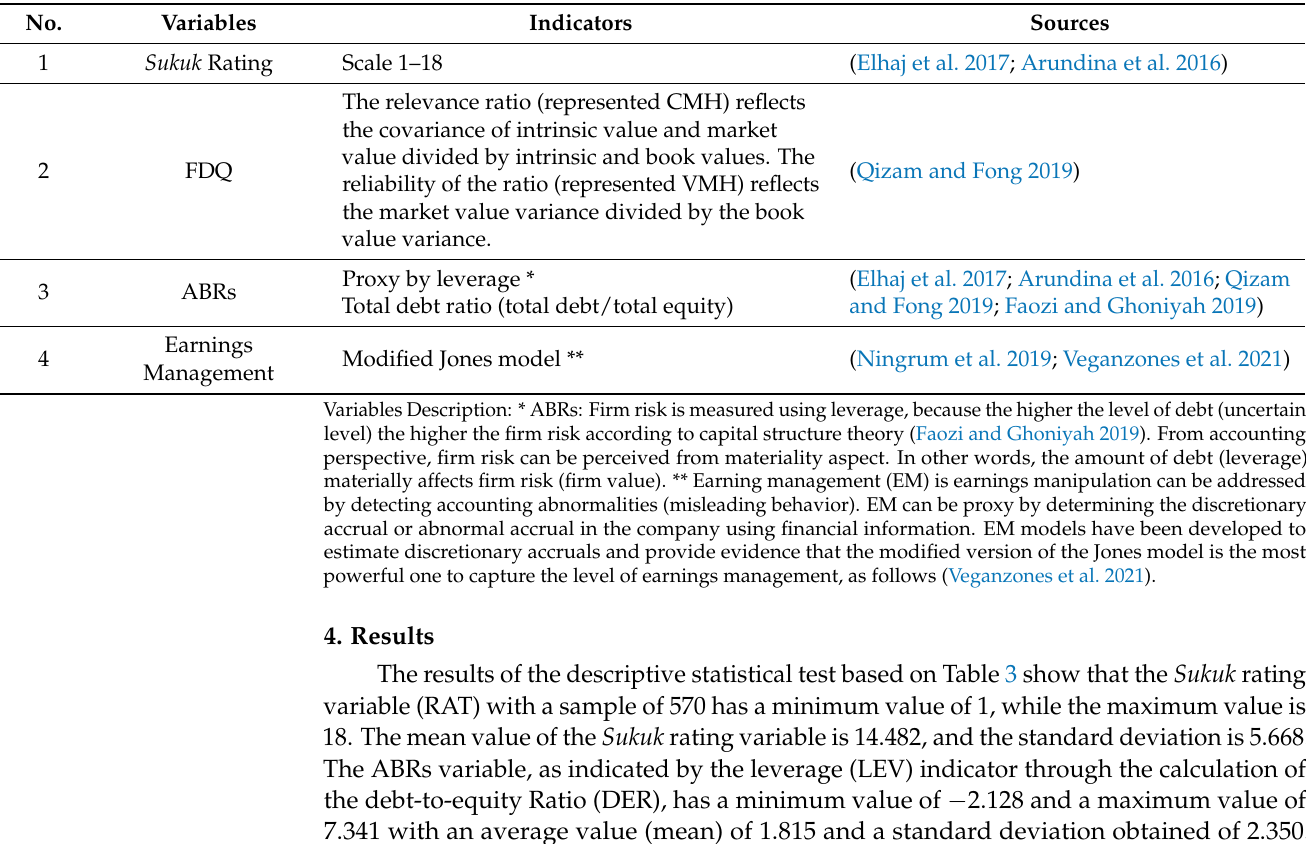
Table 2. Variable and Operational